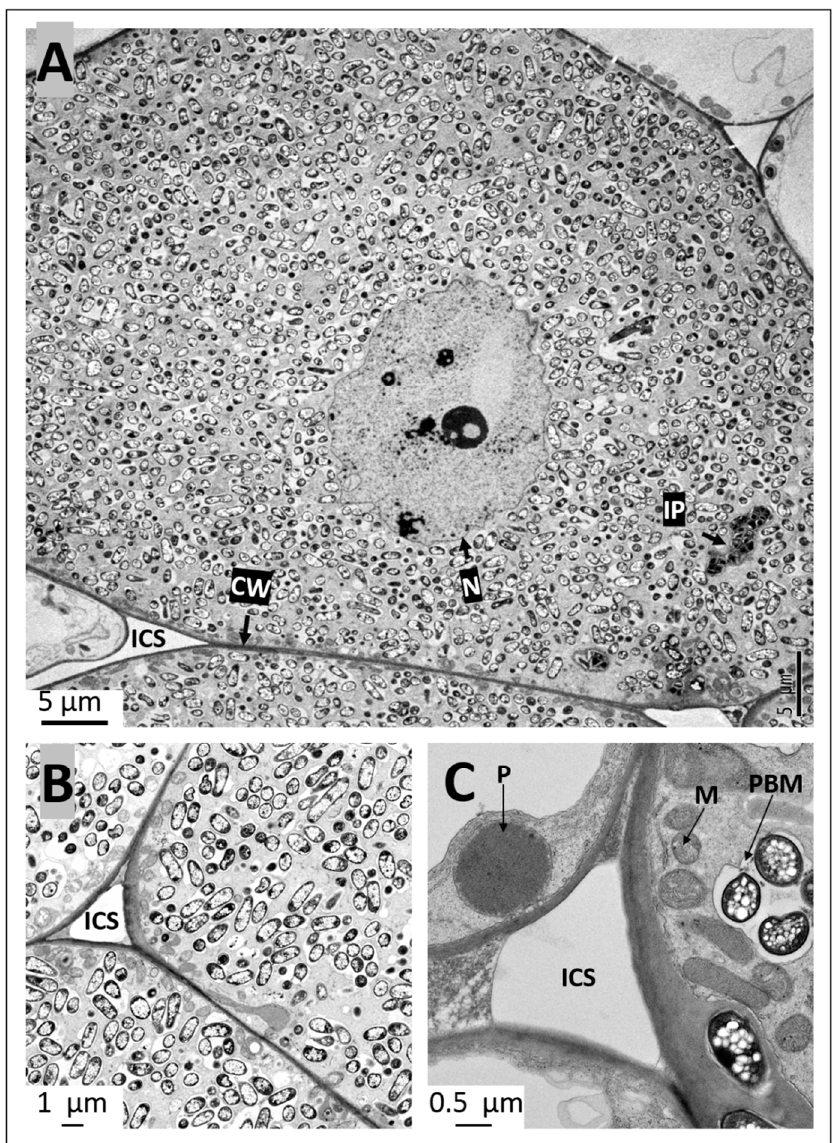
Figure 7. Transmission electron micrographs of pigeon pea nodules inoculated with S. fredii USDA RCB26. Thin sections of pigeon pea nodules at 30 DAI were examined by transmission electron microscopy. The infected cells are filled with bacteroids ( A , B ). Note the presence of infection pocket (IP) and prominent nucleus ( A ). Prominent mitochondria were seen in the infected cells ( C ) and peroxisomes were evident in uninfected cells ( C ). CW, cell wall; ICS, intercellular space; M, mitochondria; N, nucleus; PBM, peribacteroid membrane; P, peroxisome.